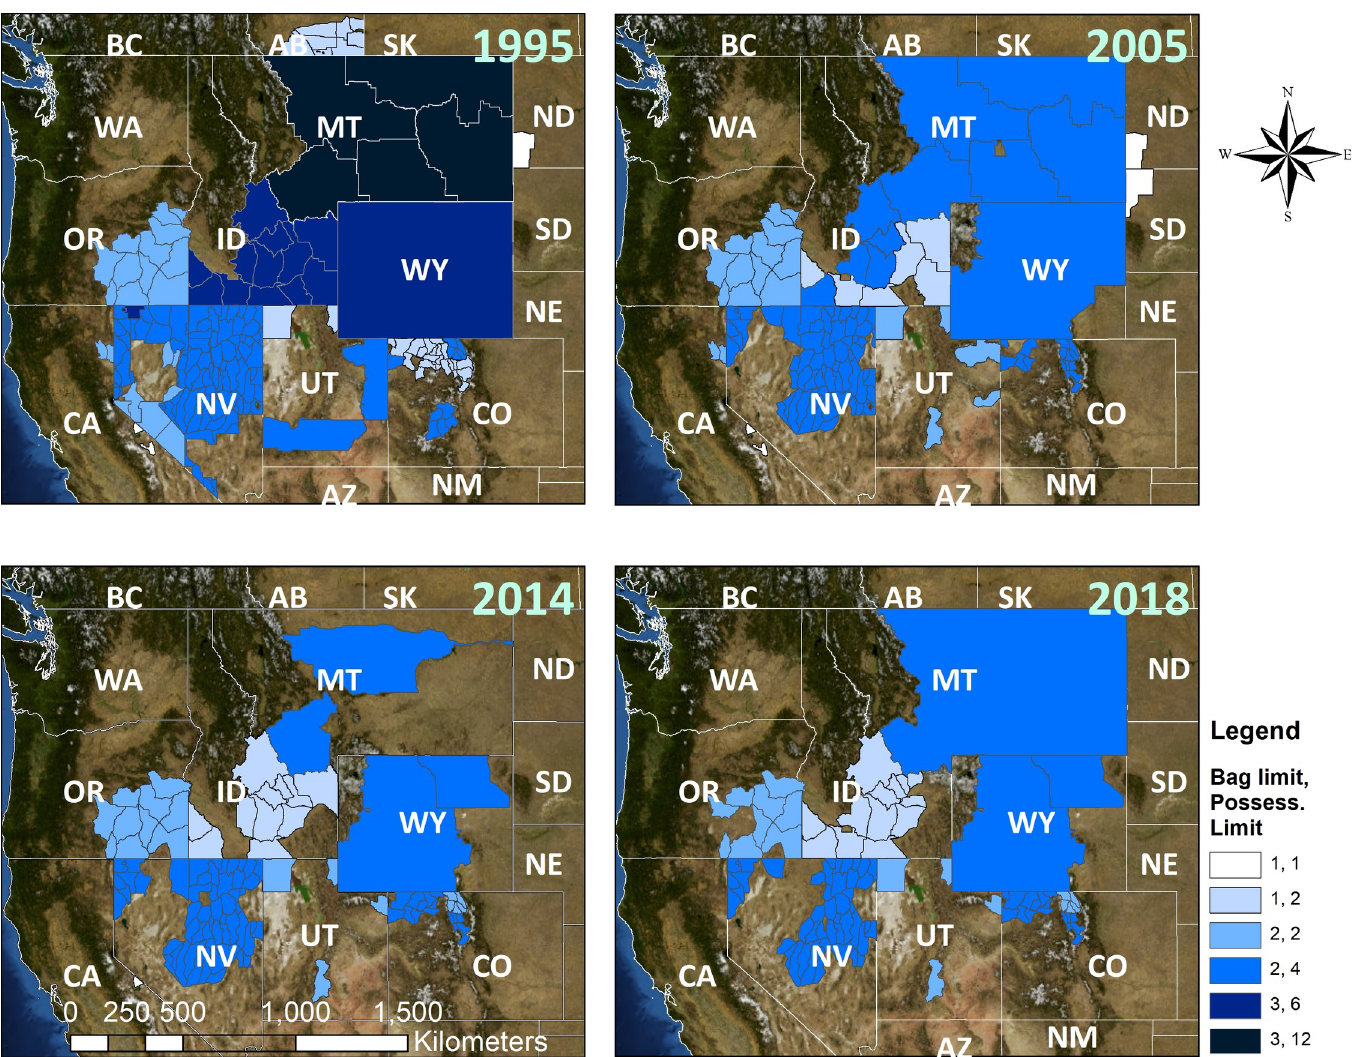
Fig 6. Bag limits, possession limits, and total hunt area for greater sage-grouse in 1995, 2005, 2014, and 2018.